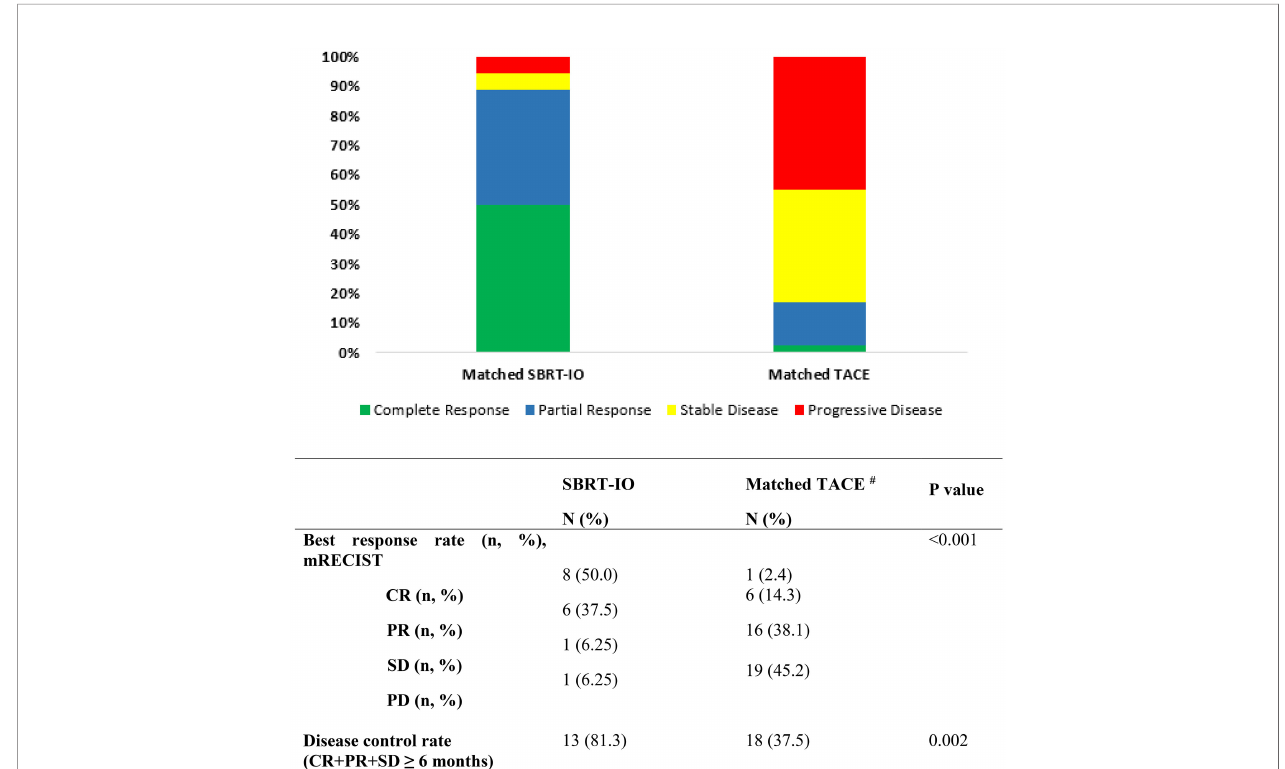
one patient (6.3%) developed progressive disease after SBRT-IO; this patient developed a new HCC focus outside the irradiated fi eld and two SBRT-treated lesions had partial response (PR) and static disease (SD). Two patients of the SBRT-IO arm (12.5%) had